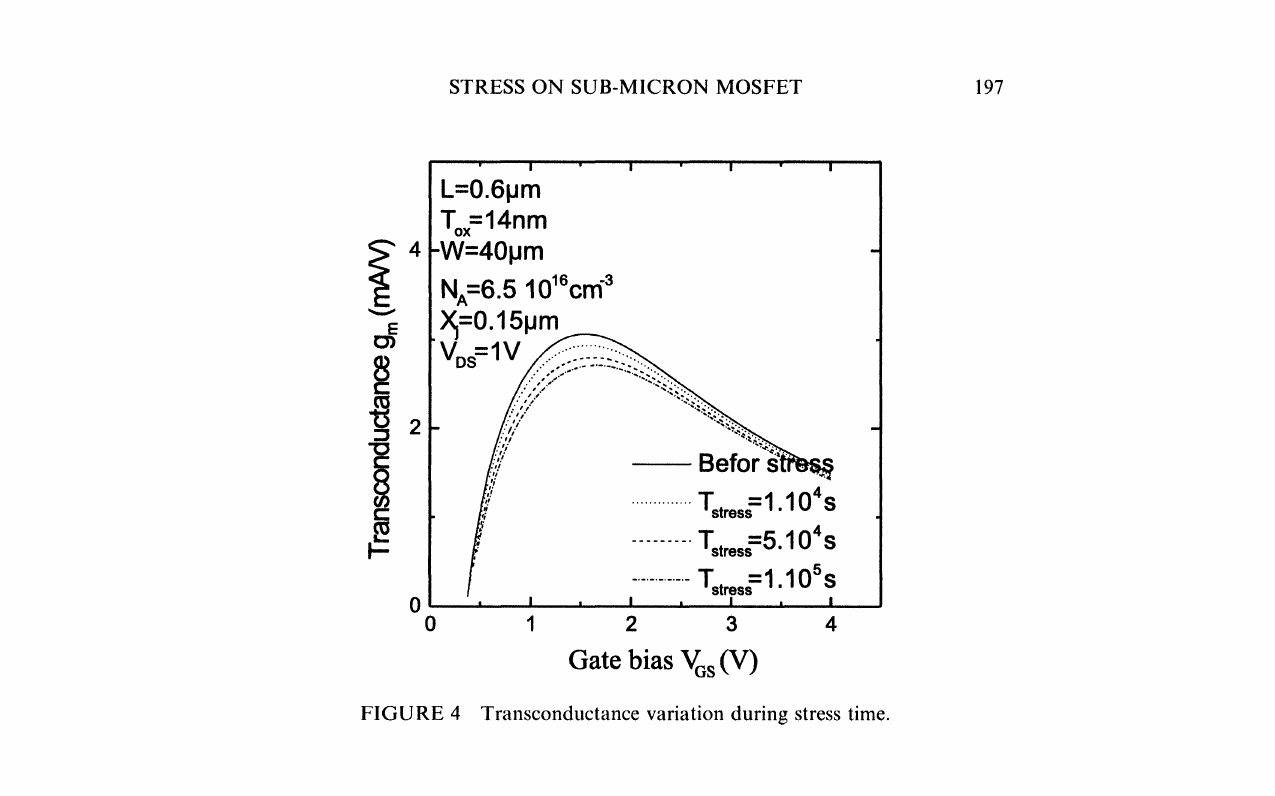
FIGURE 4 Transconductance variation during stress